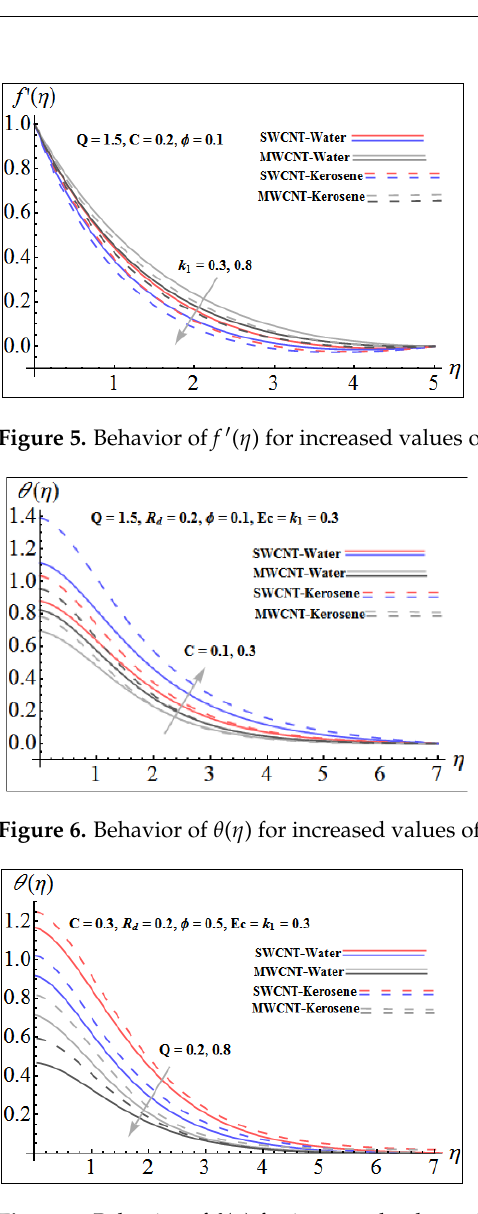
Figure 4. Behavior of f ′ ( η ) for increased values of C .